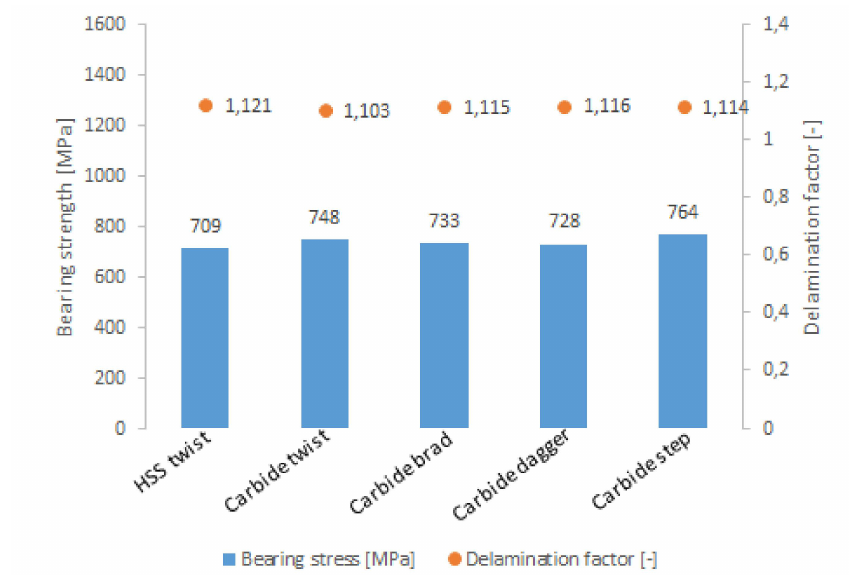
Figure 10. Results of drilling holes with the use of di ff erent types of drills on bearing strength and delamination